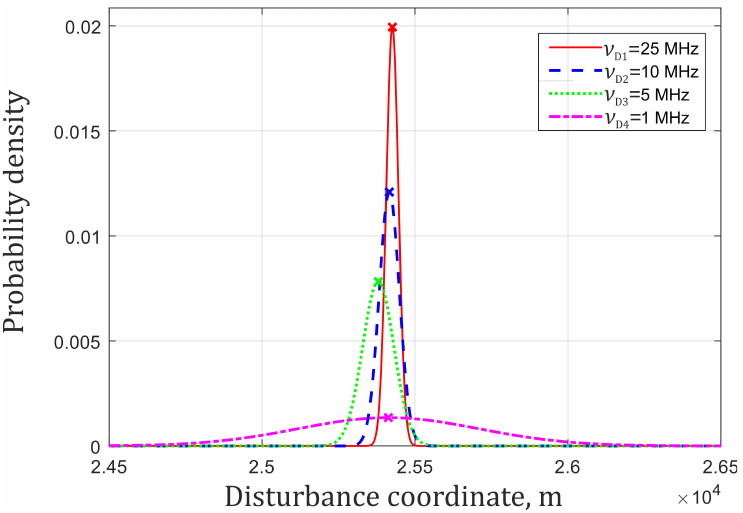
Figure 17. Gaussian approximation of z 1 obtained using interpolation algorithm for different ν D values. Table 1. System parameters in case of